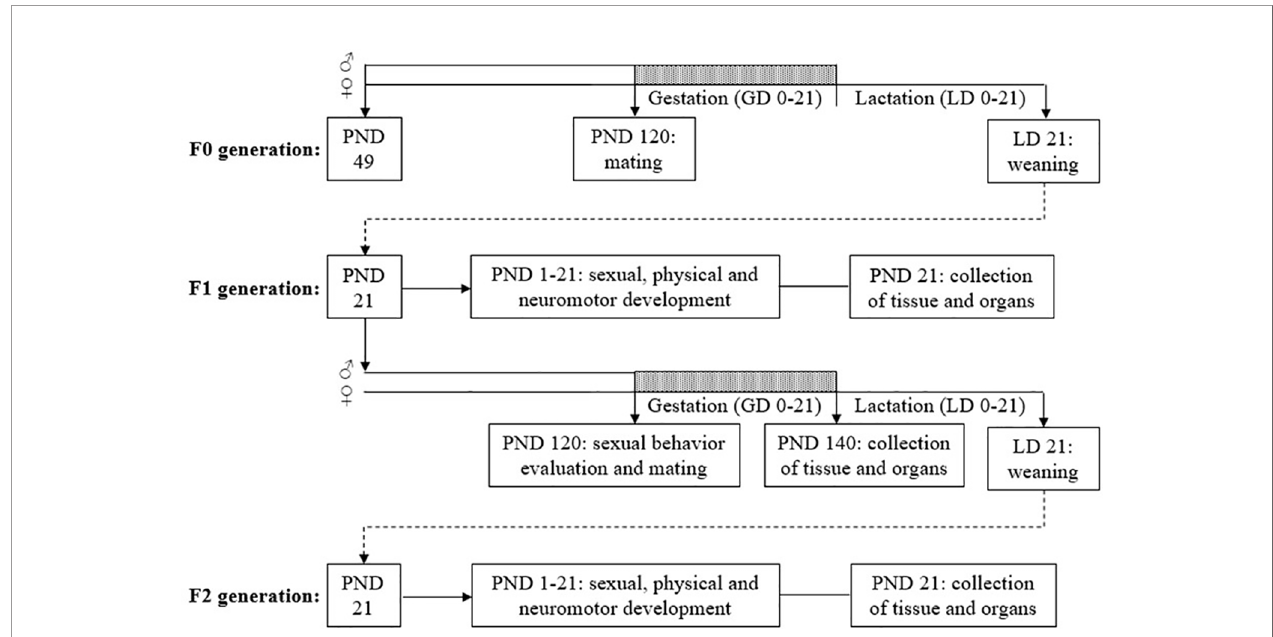
FIGURE 1 | Diagram of the experimental design. GD, gestational day; LD, lactational day; PND, postnatal